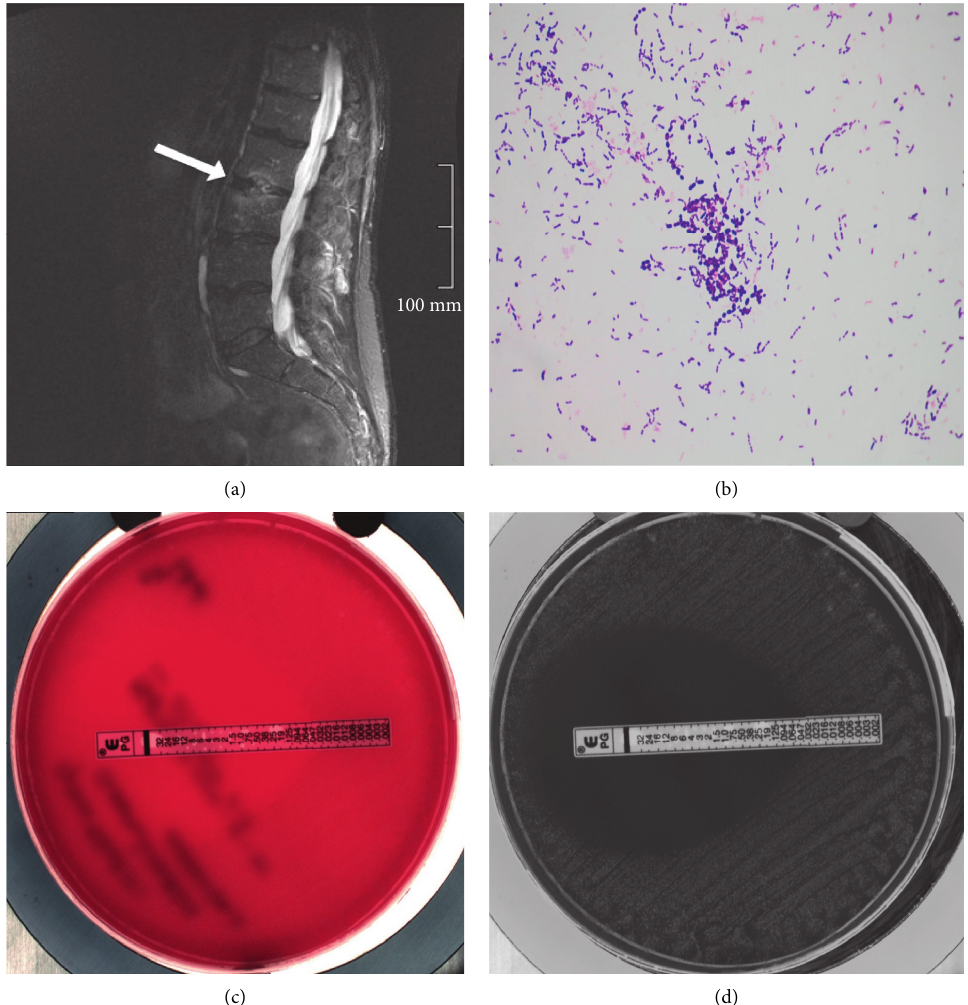
Figure 1: (a) MRI lumbar spine, T2-weighted image. (b) Gram stain of positive blood culture showing Gram-positive cocci. (c)-(d) Blood cultures and antibiotic susceptibility